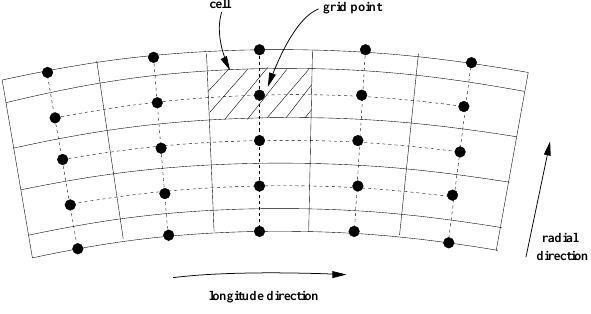
Fig. 2. Sketch showing how grid points are related to cells. Fig. 32. Sketch showing how grid points are related to cells.